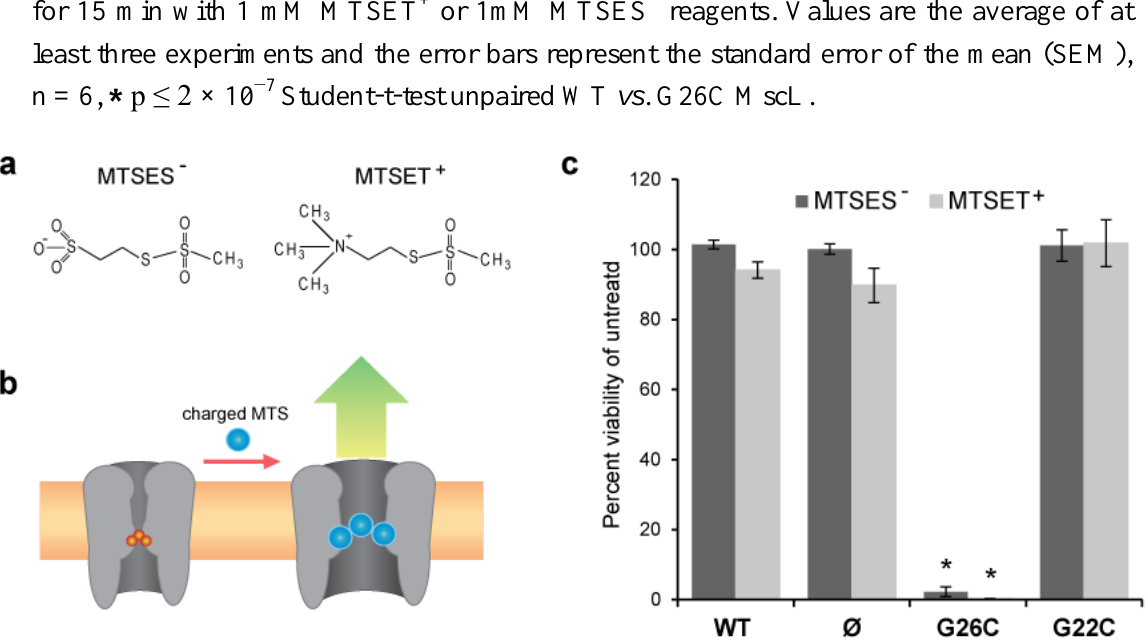
Figure 2. Effects of posttranslational modifications with methanethiosulfonate (MTS) reagents on G26C and G22C MscL function in vivo. ( a ) The chemical structures of the MTS reagents MTSES − and MTSET + are shown. ( b ) A scheme depicting the opening of the MscL nanovalve when a charged MTS reagents access the cysteine in the constriction pore. ( c ) A graph showing the change in viability of bacteria after incubation with charged MTS reagents. The values shown in the bar graphs represent the changes in survival rate of bacteria carrying an empty vector or expressing WT, G26C or G22C MscL when incubated for 15 min with 1 mM MTSET + or 1mM MTSES − reagents. Values are the average of at least three experiments and the error bars represent the standard error of the mean